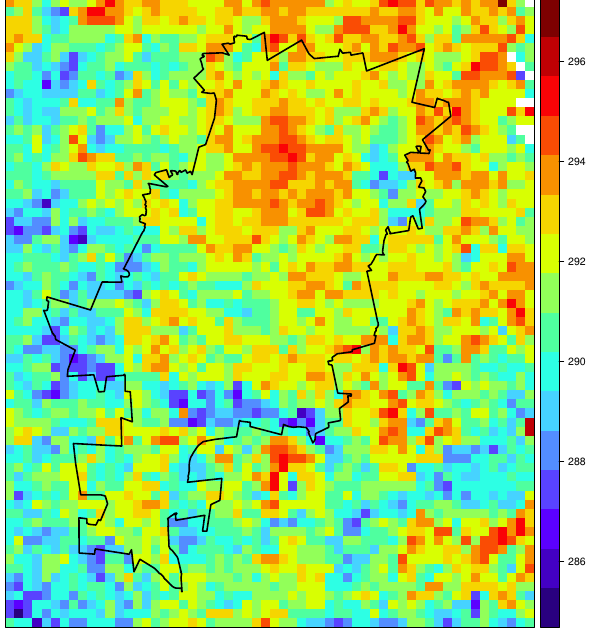
Figure 4: A land surface temperature map from AATSR data shows the night-time Johannesburg urban heat island on 14 March 2003 at 22:25 local time. The data has a nominal pixel size of 1km by